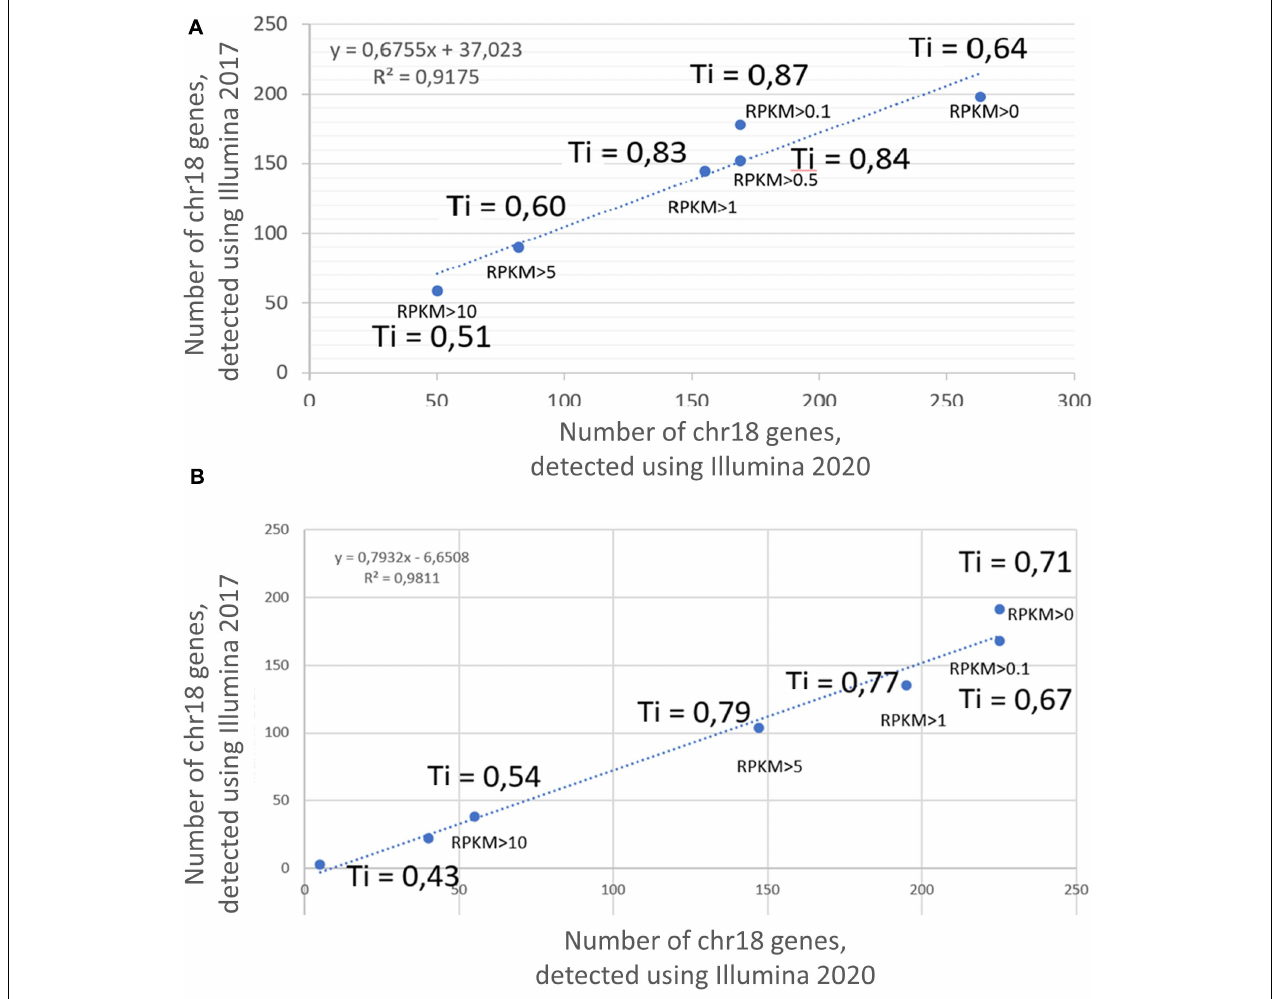
FIGURE 1 | Correlation between the results of transcriptome profiling of the (A) HepG2 cell line and (B) liver, using the Illumina platform in 2017 and 2020. X axis corresponds to the number of genes, detected using Illumina 2020; Y axis corresponds to the number of genes, detected using Illumina 2017. Ti, Tanimoto index.